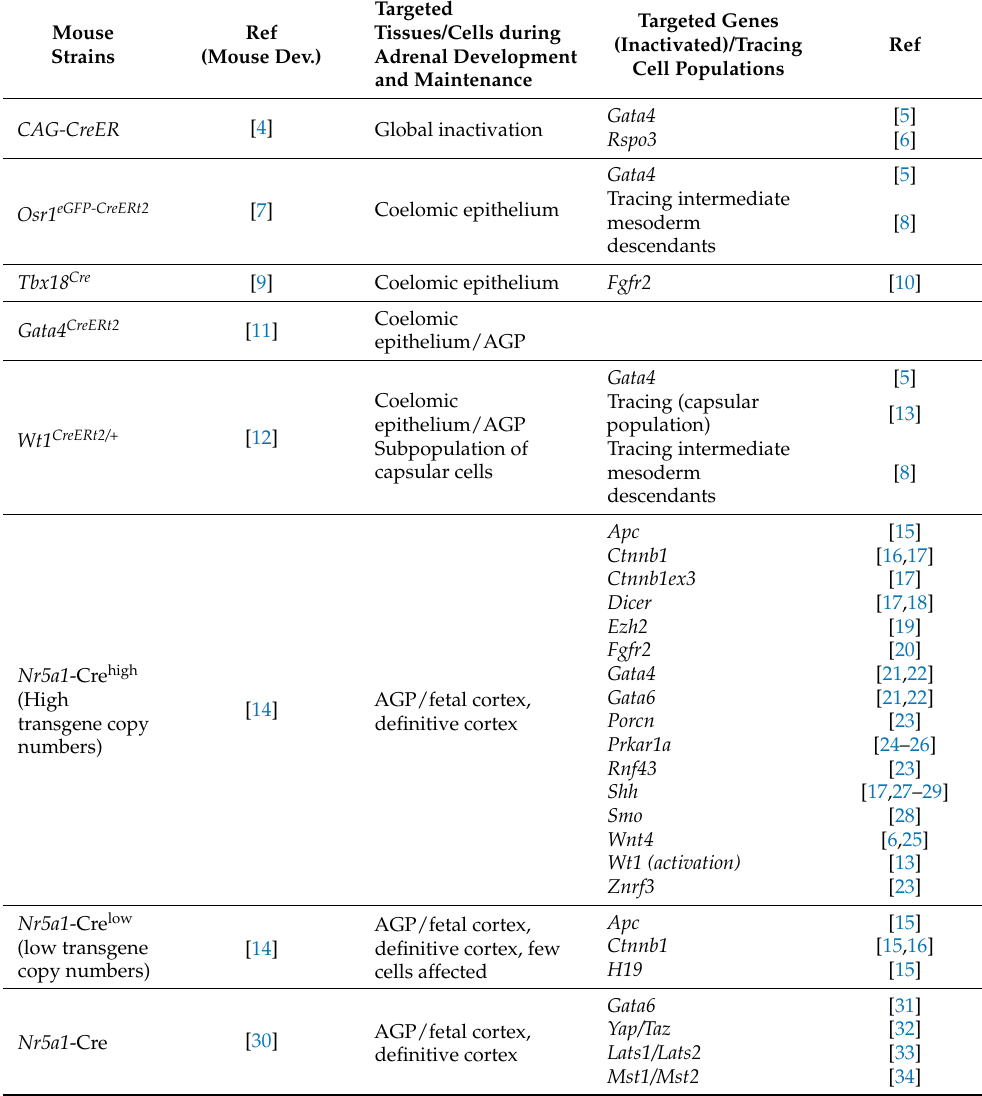
Table 1. Cre mouse strains used to study adrenal cortex development and